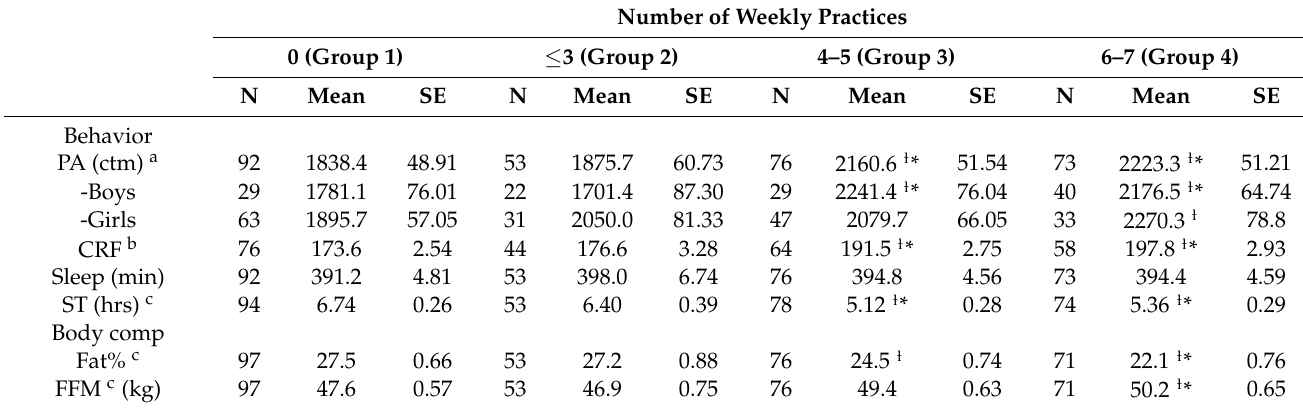
a Adjusted for sex/OSP interaction, b adjusted for sex and FFM, c adjusted for sex, ƚ significantly different from the not ‐ actively engaged group (zero practice sessions per week), * significantly different from the group with three or less practice sessions per week ( ≤ 3). PA = physical activity, CRF = cardiorespiratory fitness, ST = screen time, Fat% = body fat percentage, FFM = fat free mass. Estimated means displayed where covariates were included in the